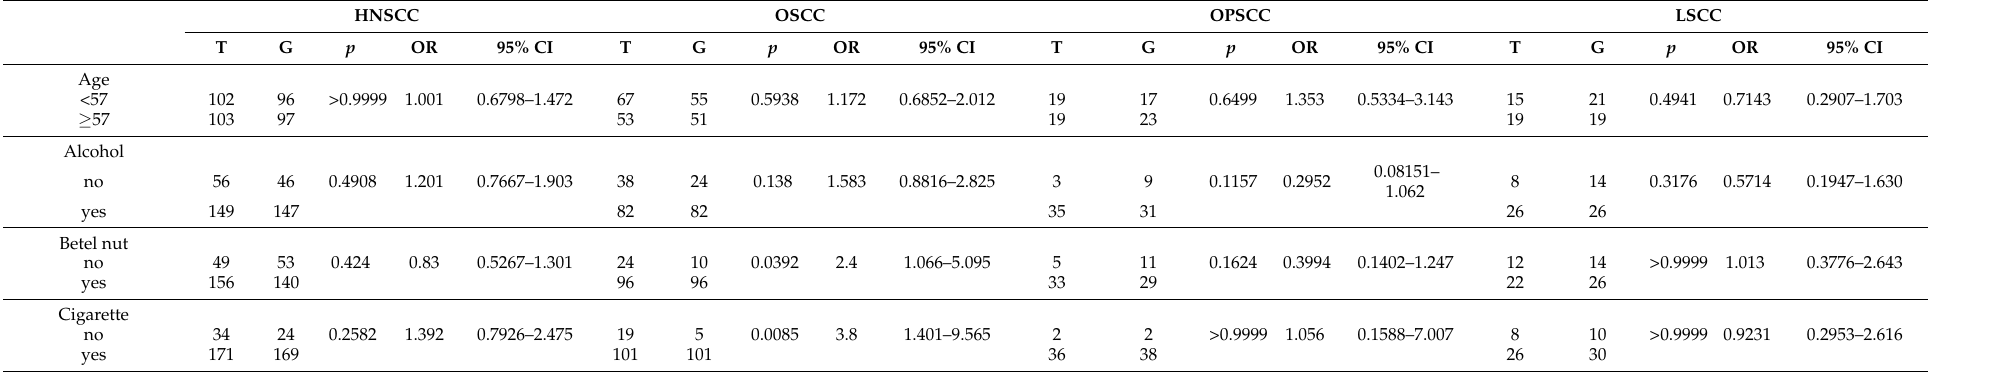
Table 2. Alleotypes of GALNT14 -rs9679162 in